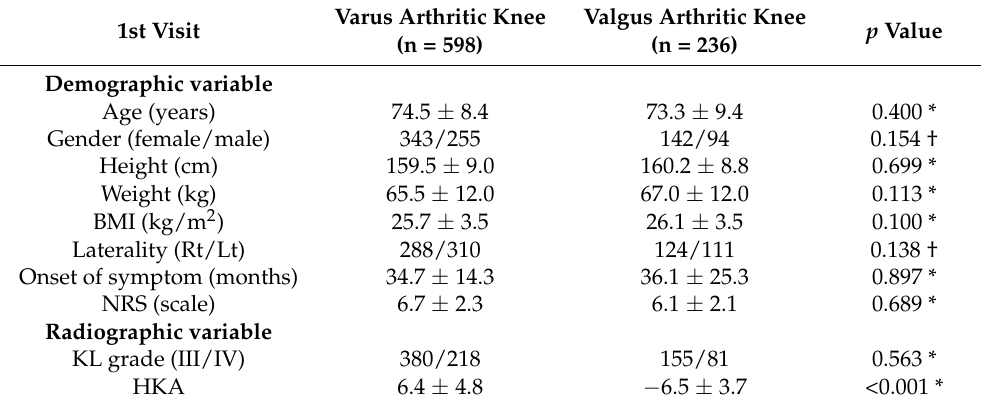
Table 2. Patient demographics and radiographic variables (varus arthritic knee vs. valgus arthritic knee).